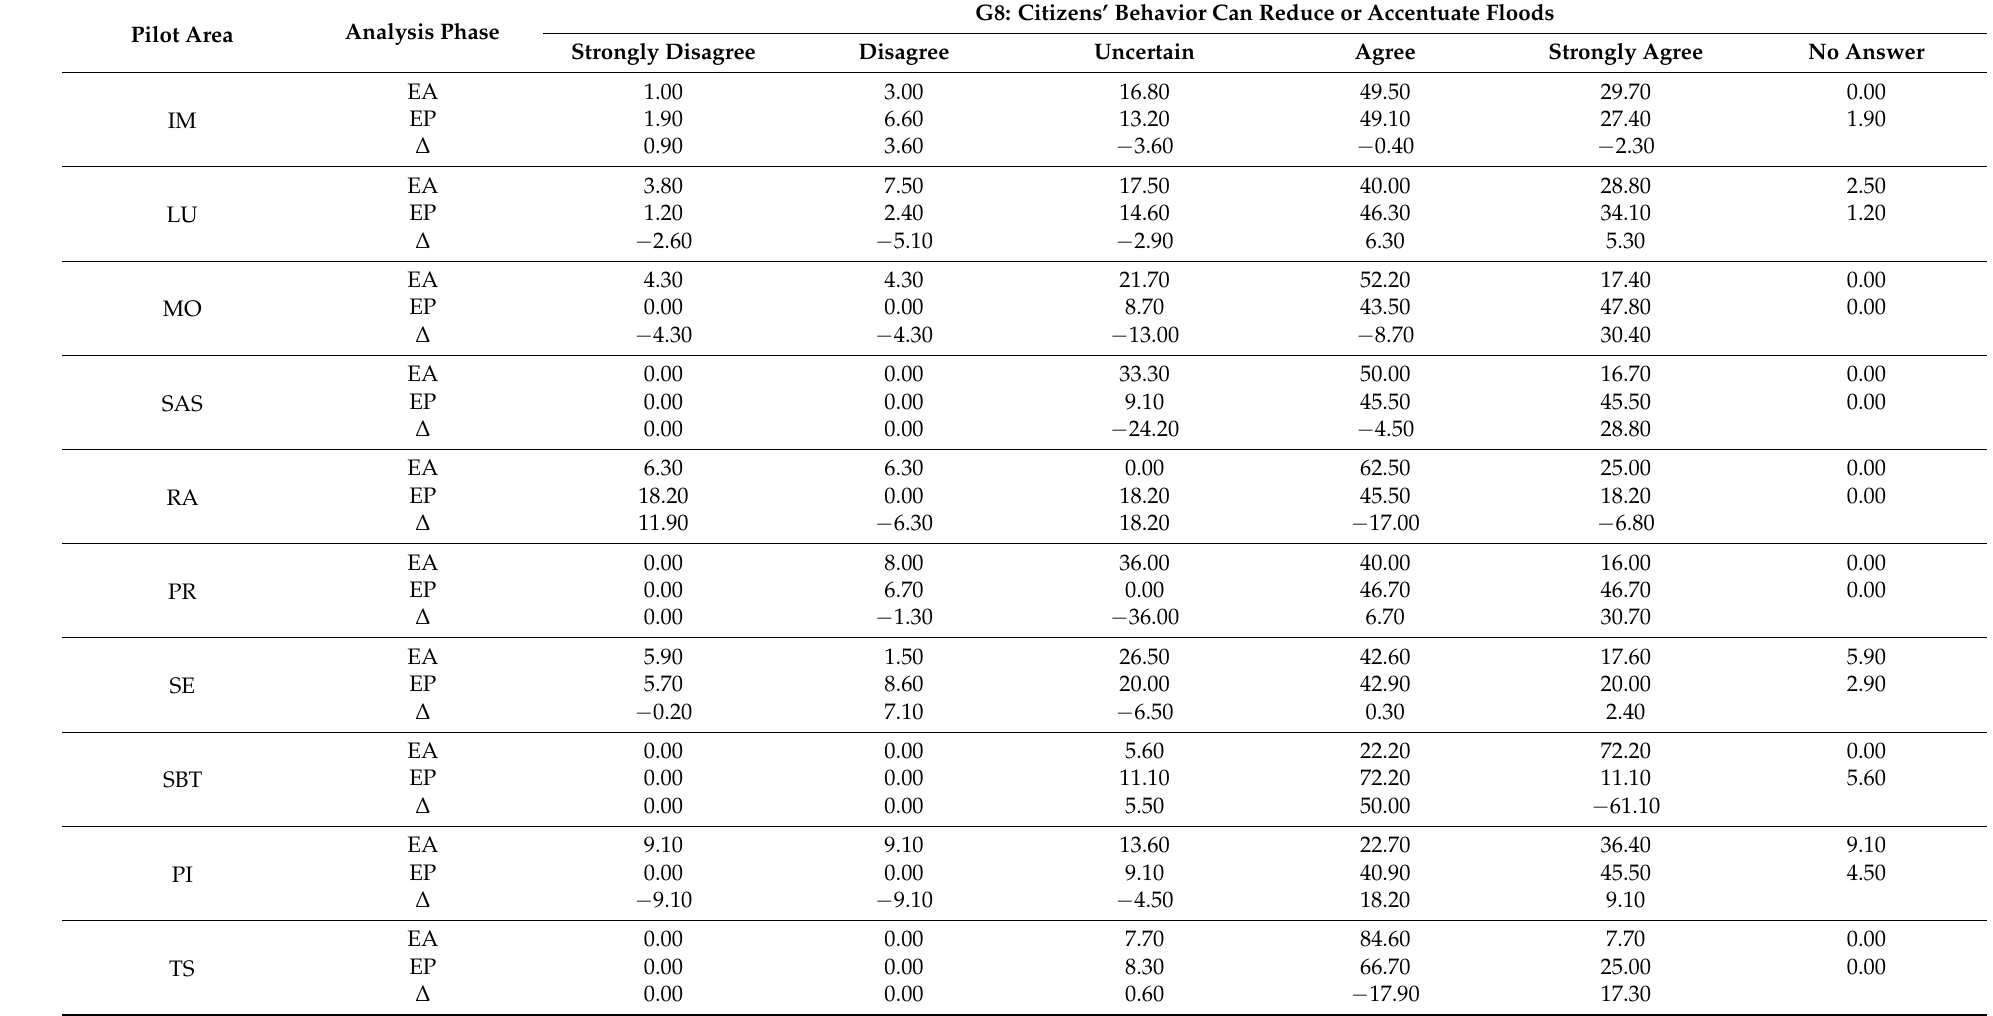
Table A9. Answers to the question G8 in percentages per each pilot area, in the ex-ante (EA) and in the ex-post (EP) phases, and their variation ( ∆